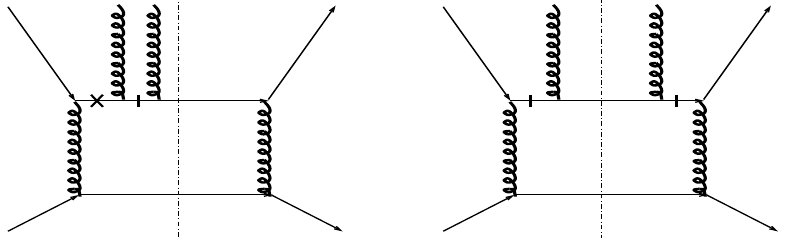
Figure 8. ( Left ) the structure of the hard “blob” in Figure 7, for leading power corrections discussed in the text, for the case of hard scattering of quarks of different flavors. ( Right ) an alternative leading power correction to the qq (cid:48) hard scattering, which provides a subleading contribution in the high energy limit. Quark propagators with a vertical dash correspond to the contact terms; the propagator marked by a cross is the pole